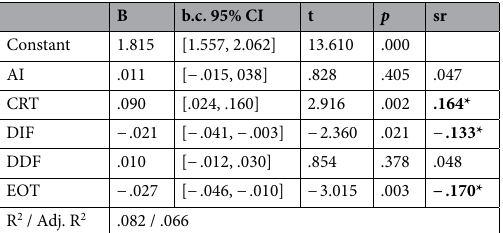
Table 3. Bootstrapped multiple linear regression model predicting Evaluation Differentiation scores (Study 2). * indicates p < .05. Significant values are in